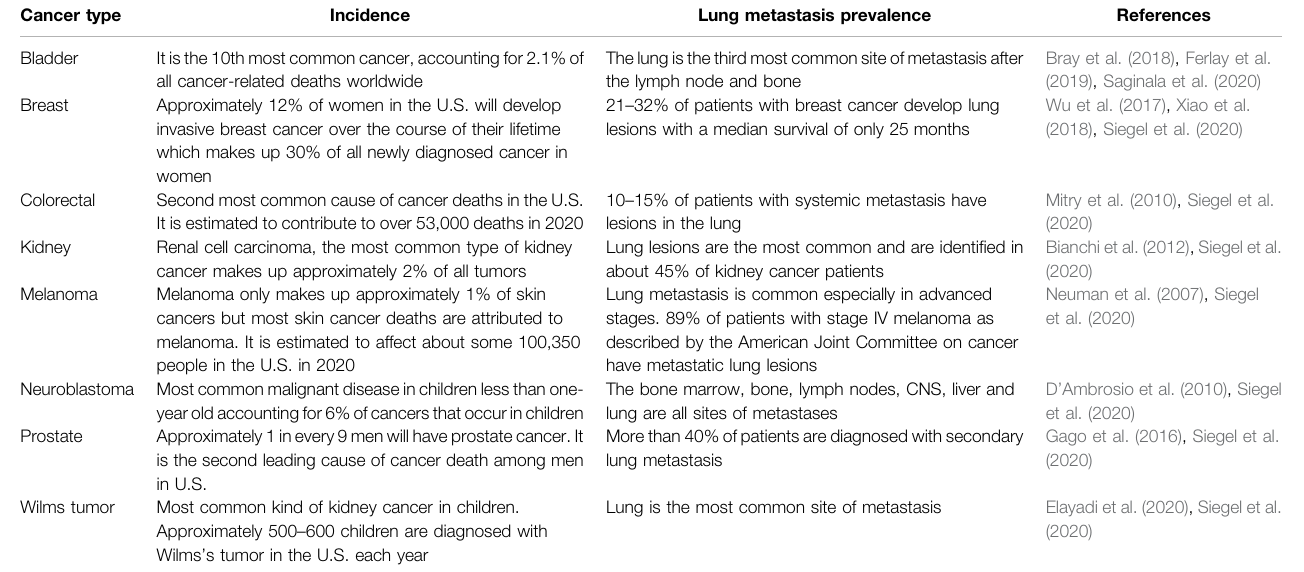
TABLE 1 | Leading primary cancers with high risk of lung